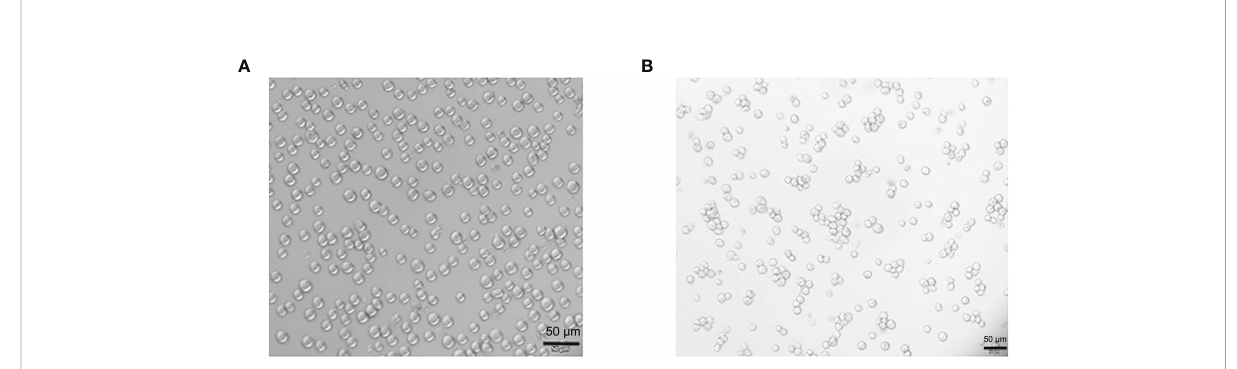
FIGURE 1 Morphological changes of THP-1 cells treated by Propylene glycol monomethyl ether acetate (PMA). (A) The suspension culture cells are round in shape, uniform in size, and they are growing in suspension. (B) PMA-induced post-adhesive cells are round or oval in shape, and they are growing anchorage-dependent. Scale bar: 50